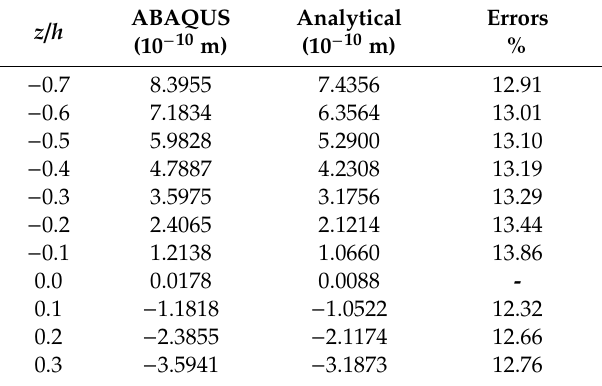
Table 5. Relative errors of two solutions of u ( x = 0.25 l ).